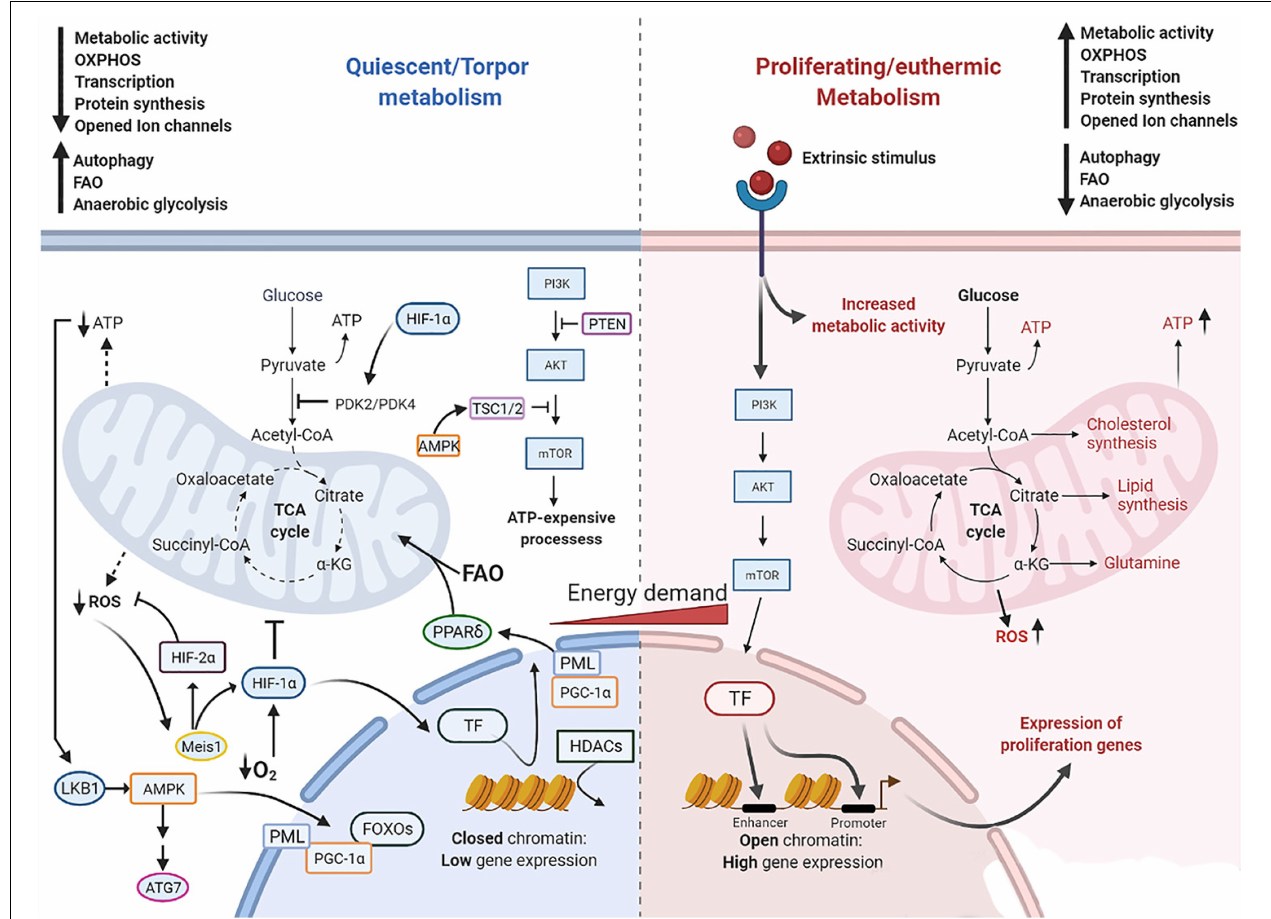
FIGURE 2 | Molecular mechanism governing cell quiescence and torpidity in contrast with cell proliferation and euthermia. Quiescent and torpid cells feature a metabolic shift from glucose fueled OXPHOS to FAO. Low nutrient supply leads to depletion of ATP which is detected by LKB1 that in turn activates AMPK, eliciting a downstream cascade including the activation of TSC1/2 that suppresses PI3K/Akt pathway and downstream ATP-expensive processes. AMPK further shuts down gene expression via activation of HDACs which tightly pack histone-DNA complexes into heterochromatin. Also, AMPK promotes autophagy by activating ULK1/ATG7, lipolysis and fatty acid oxidation via activation of OXPHOS regulator FOXOs proteins and PGC-1 α . In addition, PGC-1 α , a transcriptional coregulator of PPAR target genes, promotes the upregulation of PPAR δ . The PML-PPAR δ -FAO further promotes β -oxidation of lipids and the metabolic shift toward FAO. HIF-1 α promotes FAO via upregulation of PDK4 and inhibition of the first step in the TCA cycle, and promotes resistance to hypoxia stress and ROS damage. HIF-1 α can be activated by its upstream regulator the Meis1 protein, which is activated by the elevation of intracellular ROS, and by low levels of O 2 . Dotted lines represent a restricted generation of molecules pointed at. Solid lines represent activated pathways. T lines indicate the suppression of the pathway. AMPK, AMP-activated protein kinase; ATG7, autophagy related 7; FOXOs, forkhead proteins; HDACs, histone deacetylases; HIF-1 α , hypoxia-inducible factor 1 α ; HIF-2 α , hypoxia-inducible factor 2 α ; LKB1, liver kinase B1; OXPHOS, oxidative phosphorylation; PDK4, pyruvate dehydrogenase kinases 4; PGC-1a, peroxisome proliferator-activated receptor-coactivator 1 α ; PML, promyelocyte leukemia protein; PML, promyelocyte leukemia protein; PPARs, peroxisome proliferator-activated receptors; PTEN, phosphatase and tensin homolog; TCA, tricarboxylic acid cycle; TF, transcription factors; TSC1/2, tuberous sclerosis proteins 1 and